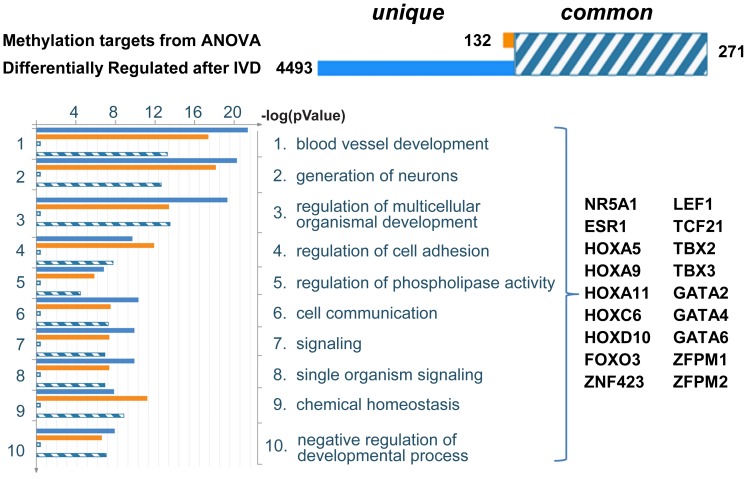
Summary of statistical comparison between ANOVA identified genes and genes differentially expressed after IVD.ANOVA interaction identified 403 genes both differentially methylated and differentially expressed between OSIS- and EIUM-. The gene expression array identified 4,764 differentially expressed transcripts between OSIS+ and EIUM+. The intersection of these two gene lists identified 271 common genes (shown at the top in hashed blue and white). In the same fashion, we examined the gene ontology cellular process terms that were similar between the two groups, to look for differentially methylated genes and transcription factors that may serve as pathway hubs during IVD. The most overrepresented terms were determined for the both groups of genes. The intersection of similar GO terms was then sorted based on p-value (bottom left), and the gene symbols for transcription factors common to both groups that contributed to this list of GO terms are listed (bottom right).